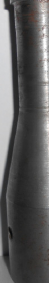
Table 2. Material properties of copper.